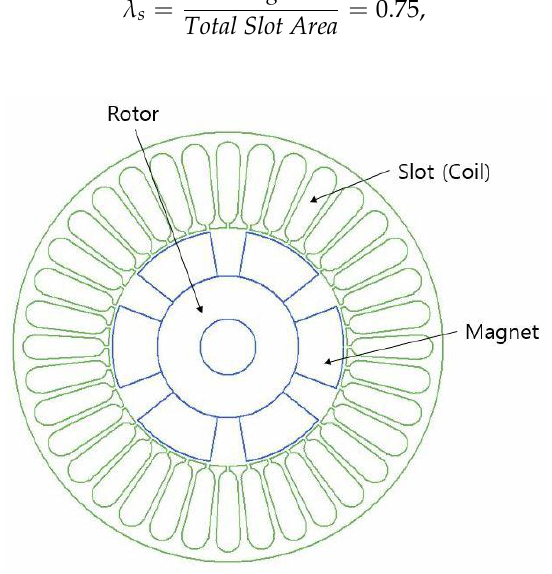
Figure 13. A 6 pole, 3 phase, 36 slot generator.